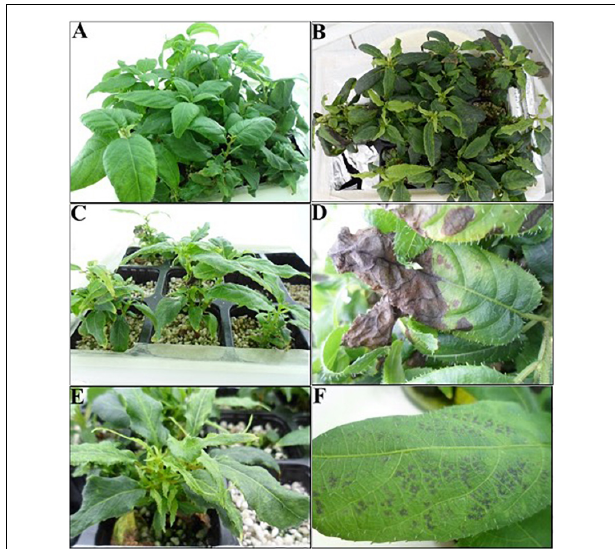
FIGURE 2 | Growth quality of A. arguta plants watered with some mineral formulations in addition to physiological disorders observed in suboptimal media. (A–C) plants watered with (A , B) , and control formulations, respectively. Physiological disorders detected during plant acclimatization: (D) leaf necrosis, (E) curling leaf, and (F) leaf spot